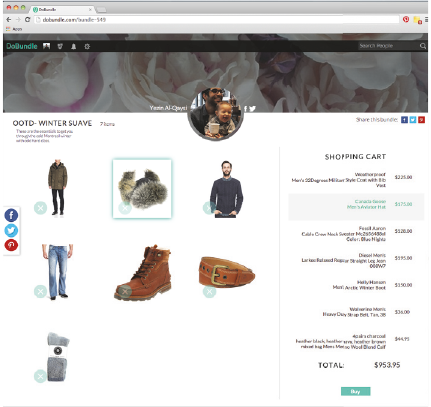
Figure 10: A snapshot of what a product collection page looks like. The page stores the products online store user has matched to their photo, a cart section, the online store’s info, and links to more collections created by the store.